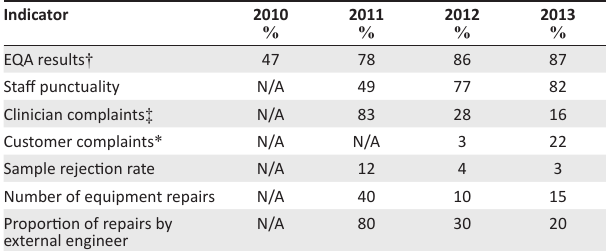
FIGURE 2: Cause-and-effect TABLE 1: Summary of quality indicators before and after SLMTA implementation.